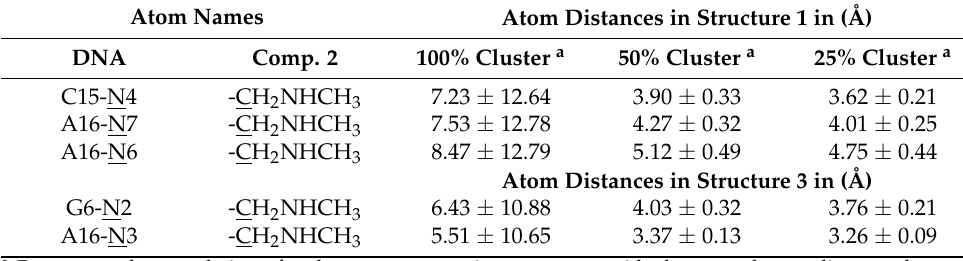
Table 5. The interatomic distances between atoms potentially interacting to form a hybrid (Figures S11 and